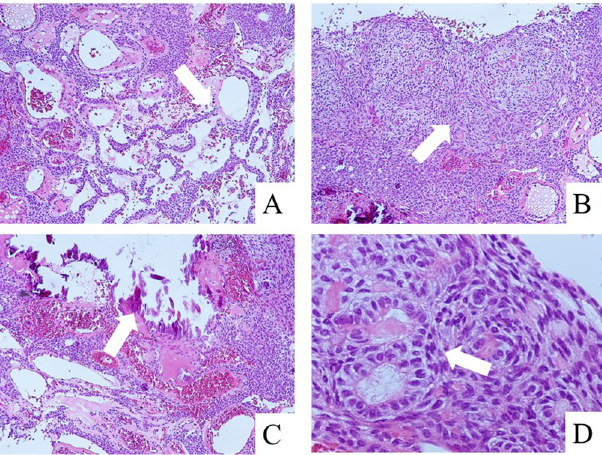
Fig. 5. Histopathological examination revealed sheets, ducts (A: arrow), and whorls (B: arrow) of darkly staining ovoid to round epithelial cells suggestive of odontogenic epithelial cells. A few basophilic calci fi cations were also observed (C: arrow). The duct-like structures were lined by columnar cells (D: arrow).